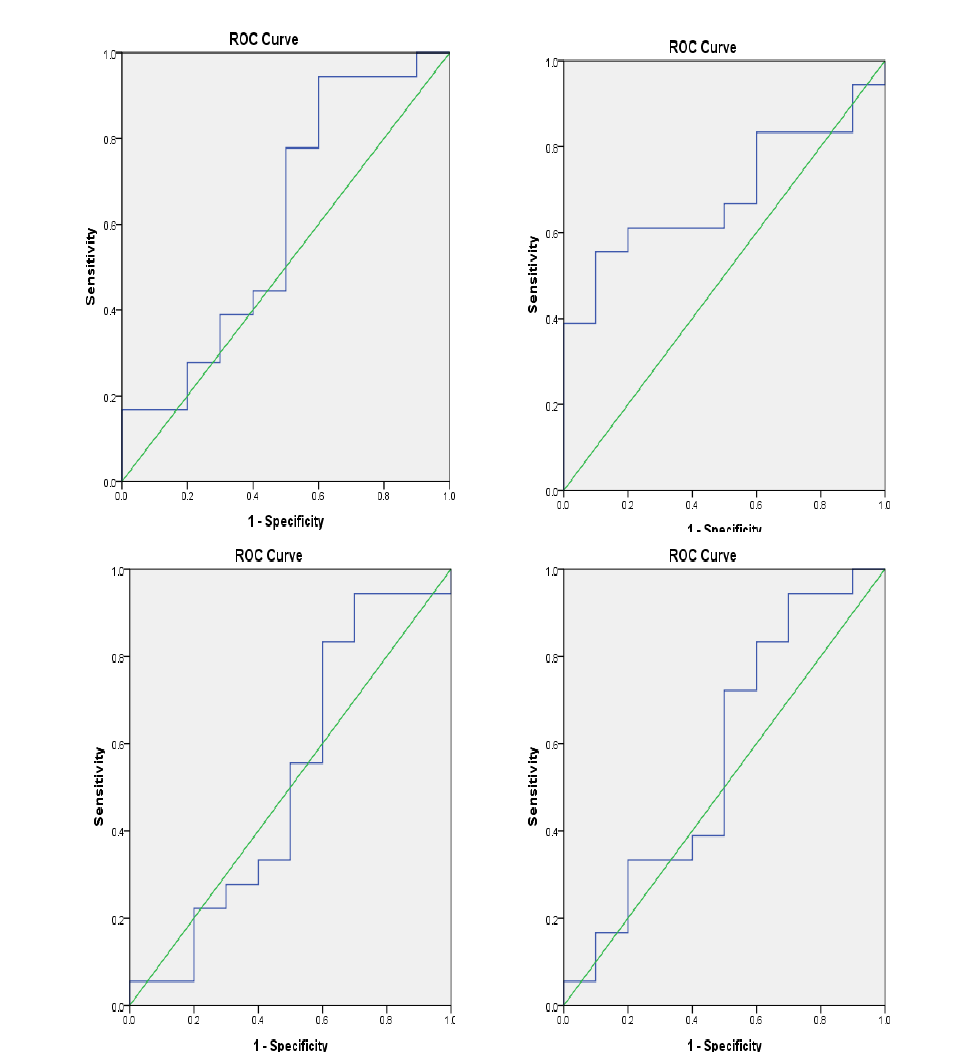
Figs. 4a. Comparative of Sensitivity and Specificity of the genus/taxa to predict T2DM, (A) Specificity and Sensitivity of the Escherichia to predict T2DM, (B) Specificity and Sensitivity of the Streptococcus to predict T2DM, (C) Specificity and Sensitivity of the Bacteroides to predict T2DM, (D) Specificity and Sensitivity of the Ruminococcus for the Prediction of